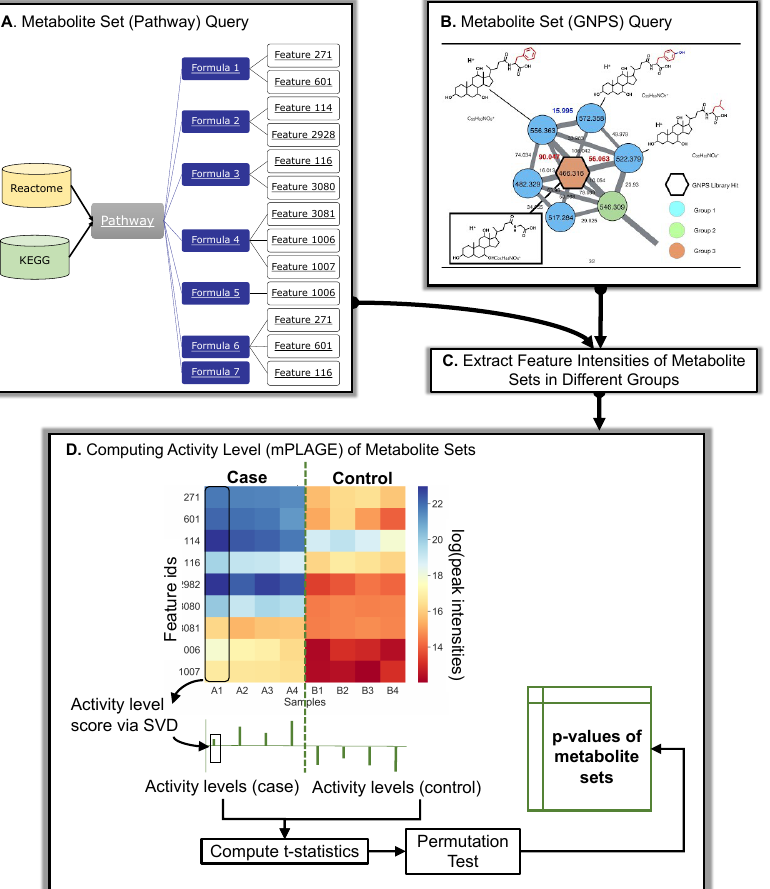
Figure 7. Overall schematic of Pathway Activity Level Scoring (PALS) using pathways and molecular families as an example of metabolite sets. ( A ) Database queries of pathways. Different databases (Reactome and KEGG) can be used to query pathways in PALS. Features are mapped to pathways through their formula annotations. For a set of compounds, all features sharing the same formula annotations of those compounds are used to construct the input intensity matrix for